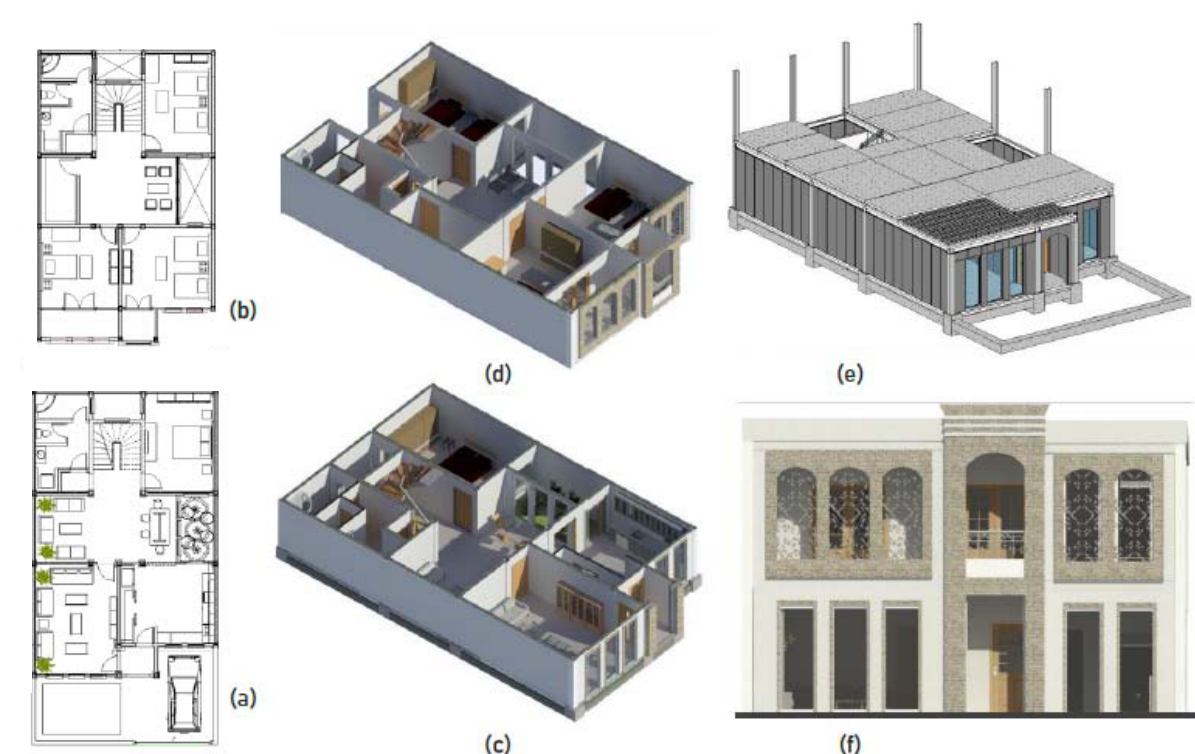
Figure 2. Prefabrication prototype; ( a ) Ground floor plan, ( b ) First floor plan, ( c ) Ground floor model, ( d ) First floor Model, ( e ) Unit structure (prefabrication elements), ( f ) House unit model.